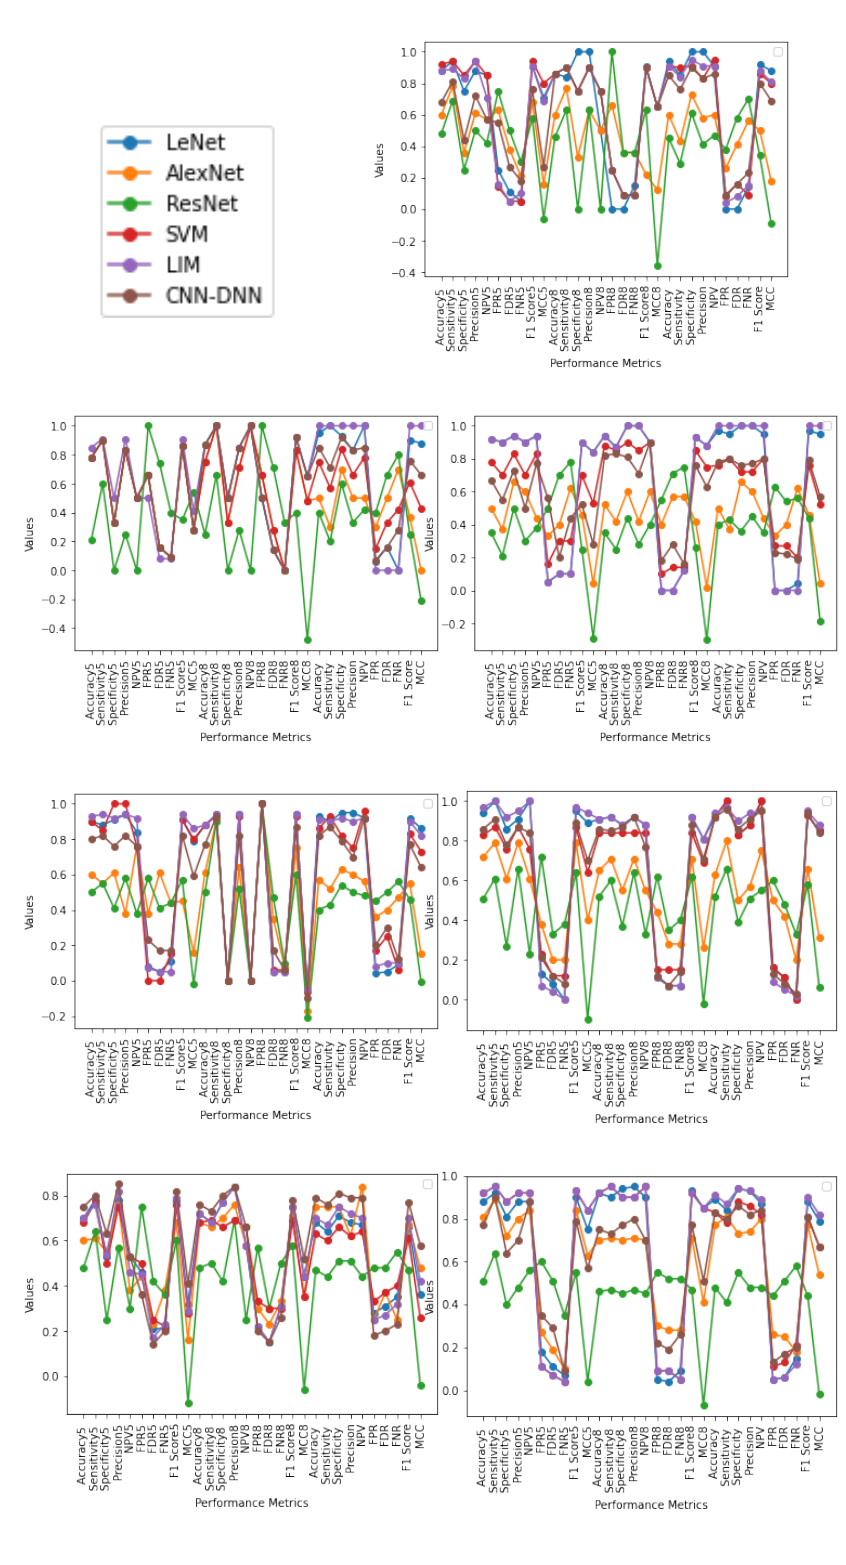
Figure 5. The graphs illustrate the Accuracy, Specificity, Sensitivity, Precision, Recall, F1 Score, NPV, FPR, FDR, FNR, and MCC of LeNet, AlexNet, ResNet, SVM, LIM, and CNN-DNN for Male (20–70), Female (50–70), Female (20–70), Male (10–80), Female (10–80), Male + Female (10-80), and Male + Female (10–80), respectively. Represented as five-fold with ending 5, eight-fold with ending 8, and generalization approach for each performance metrics with values ranging from − 1 to